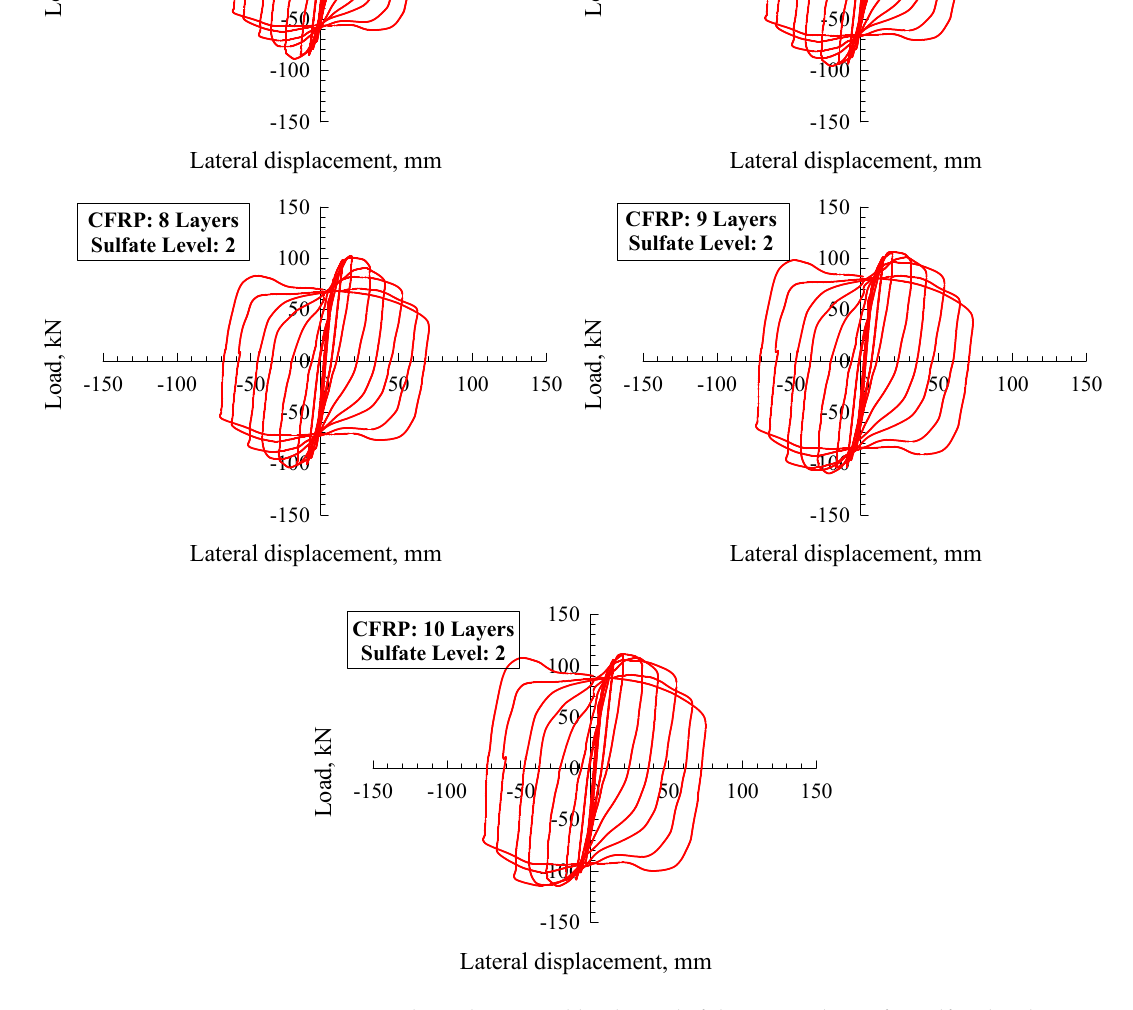
Figure 9. CFT column horizontal load–net drift hysteresis loops for sulfate level 2.